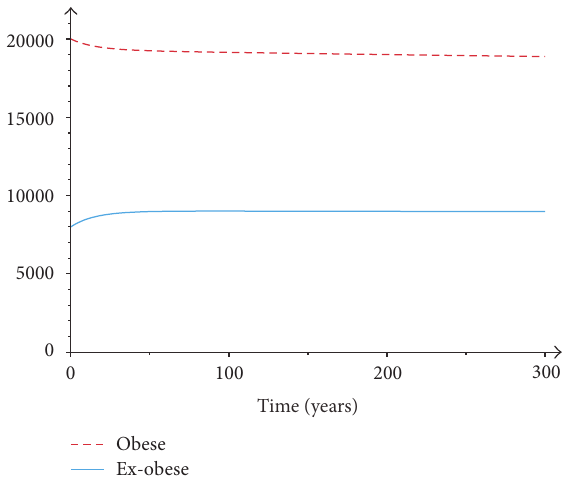
Figure 11: Infected (obese) and recovered (ex-obese) individuals as function of time. Here 𝜖 = 0 , 𝑅 0 = 𝑅 ∗ 0 and the initial condition is (𝐼(0),𝑅(0)) = (20000, 8000) .